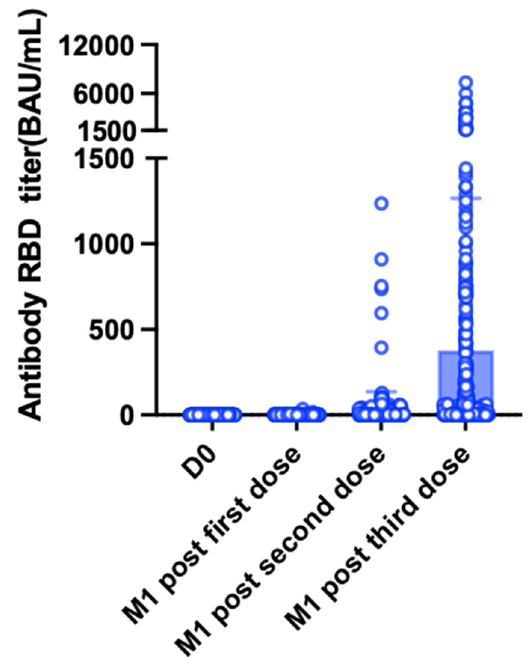
Figure 6. Antibody titer over time. Assessments were performed on the vaccination day (D0, n = 309), one month (M1) after the first dose, one month after the second dose, and one month after the third dose in the subgroup of KTRs who received three vaccine doses. White dots represent individual values, whereas blue bars and the black lines indicate the means and standard deviations, respectively. After the third dose, antibody titers increased significantly from 142 ± 637 BAU/mL to 598 ± 864 BAU/mL ( p < 0.0001). Table 5. Univariate and multivariate analysis of predictors factors for seroconversion after three vaccine doses.